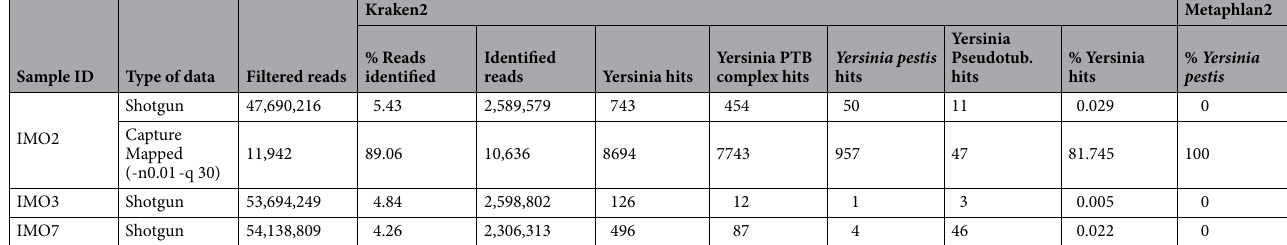
Table 2. Results of the metagenomic analysis of shotgun and target enrichment datasets using Kraken2 (Wood et al. 17 ) and Metaphlan2 (Segata et al. 18 ). Kraken2 records the number of hits for each taxon and Metaphlan2 the abundance of identified reads assigned to each taxon. Mapped data denotes reads extracted from a mapping to the CO92 reference genome.